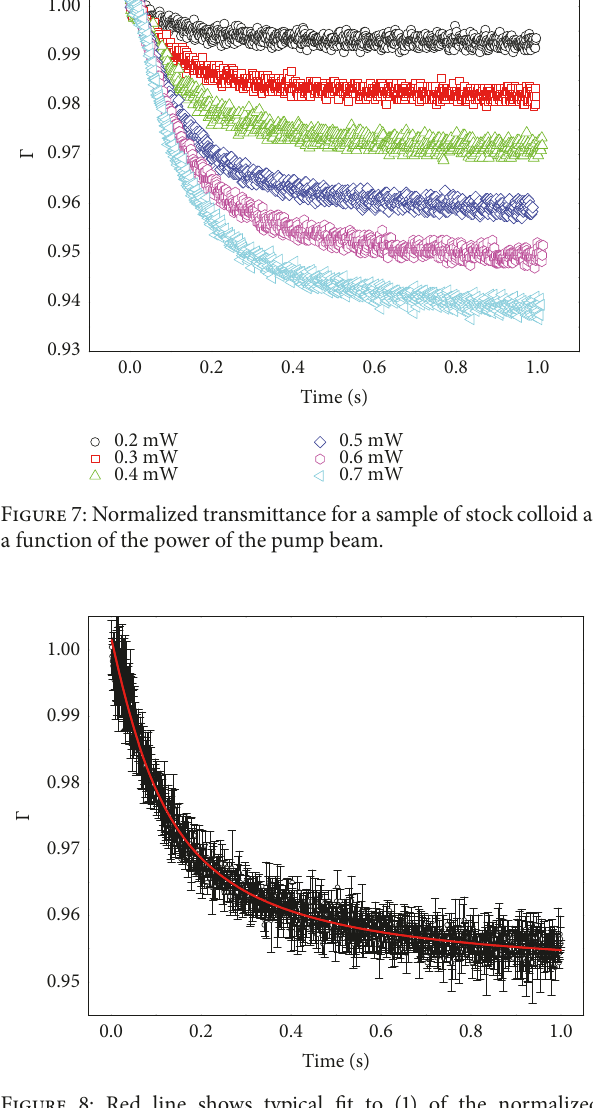
Figure 8: Red line shows typical fit to (1) of the normalized transmittance in the first half of the